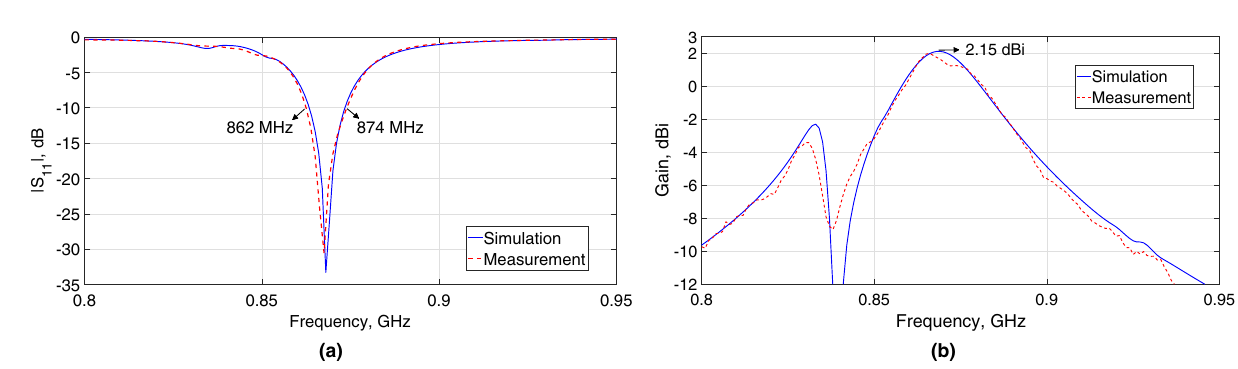
S 11 and ( b ) gain characteristics of the proposed | |